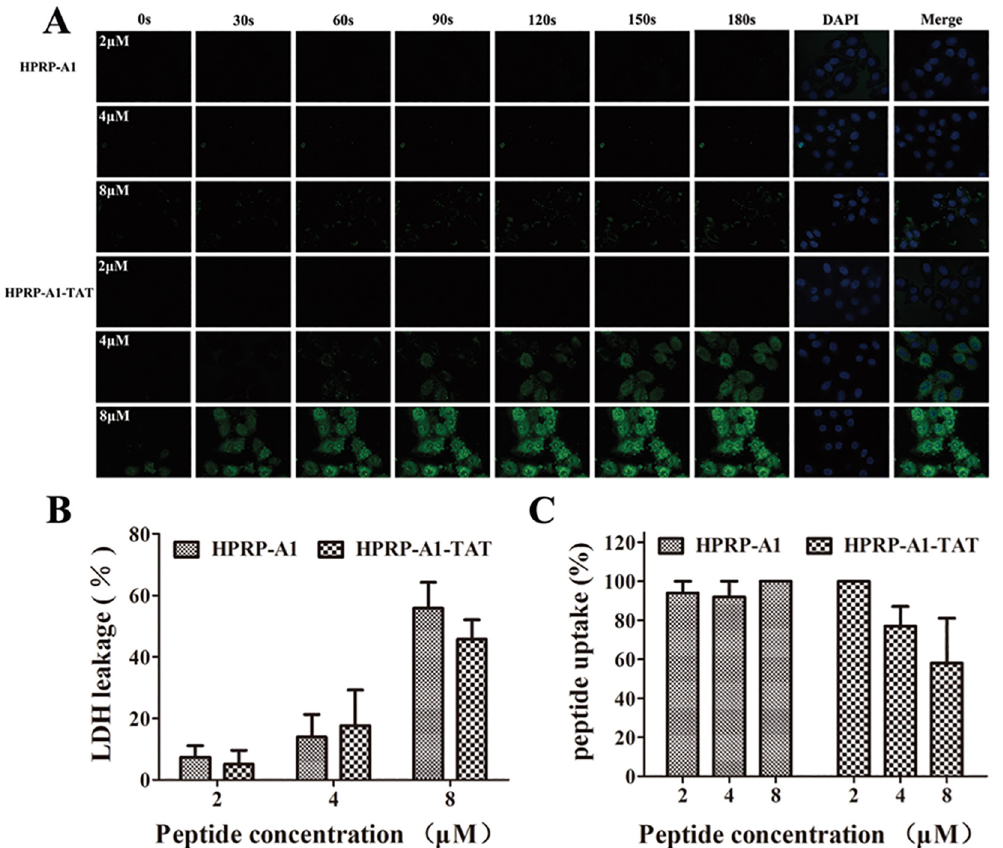
Fig 2. Cellular uptake and interaction between peptides and cell membranes. ( A ) The fluorescence time profiles of interaction between peptides and membranes. HeLa cells were incubated with different concentrations of FITC-labeled HPRP-A1 and HPRP-A1-TAT at concentrations of 2, 4, and 8 μ M. Images (400× magnification) were captured by laser scanning confocal microscopy every 30 s from 0 to 180 s. Green, FITC peptides; blue, 4,6-diamidino- 2-phenylindile-stained nuclei. ( B ) LDH leakage assay. HeLa cells were incubated with HPRP-A1 and HPRP-A1-TAT at 2, 4, and 8 μ M for 1 h and LDH assayed. ( C ) Cellular uptake of peptides, measured by flow cytometry. After incubation for 1 h at 4°C, HeLa cells were incubated with FITC-HPRP-A1 or FITC-HPRP-A1-TAT peptides for 1 h. The cells were those cultured and treated with peptides at 37°C were used as controls. Data are presented as the mean ± SD of three independent experiments. LDH, lactate